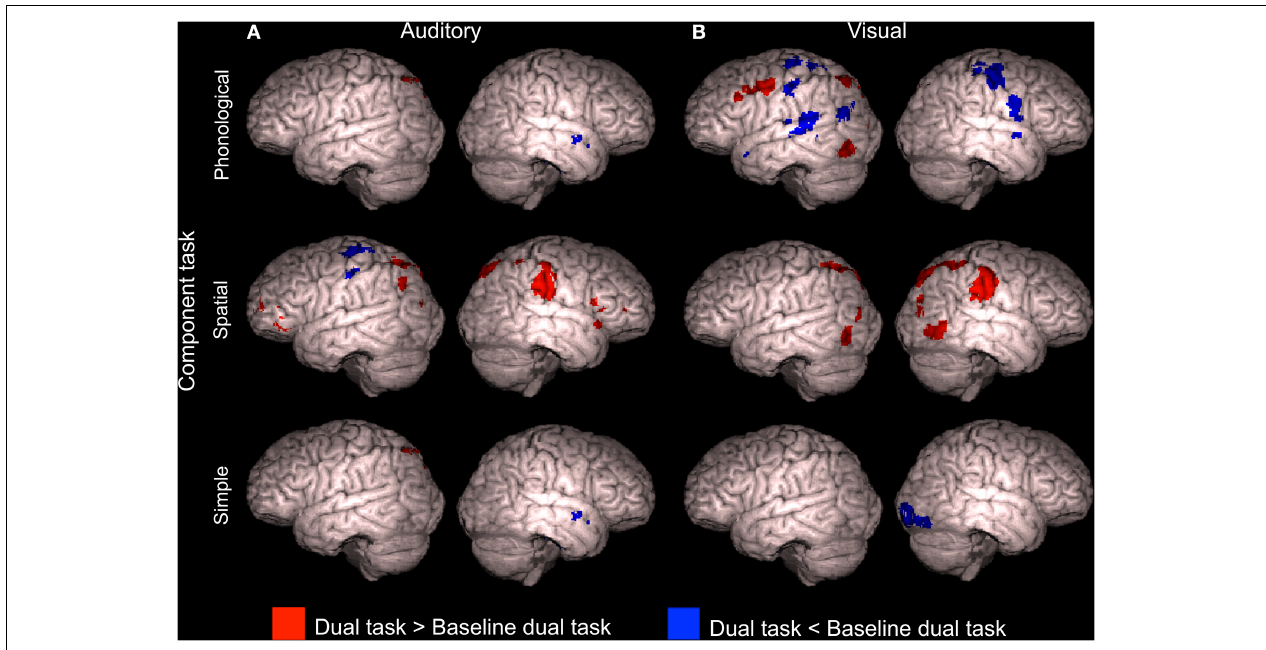
FIGURE 4 | Brain activity during dual tasks including a certain component tasks. Areas showing significant ( Z > 2 . 3, cluster corrected P < 0 . 05) activity during dual tasks including (A) auditory phonological (A Phon V Phon , A Phon V Spat , and A Phon V Simp ), spatial (A Spat V Phon , A Spat V Spat , and A Spat V Simp ) or simple (A Simp V Phon and